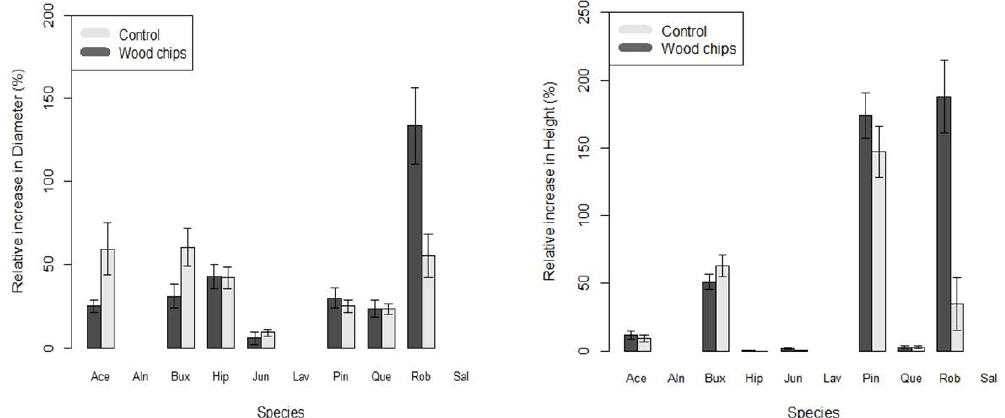
Figure 6. Relative increase in height (%, left) and relative increase in diameter (%, right) after three growing seasons. Bars indicate SE (see species abbreviations in Table 1).